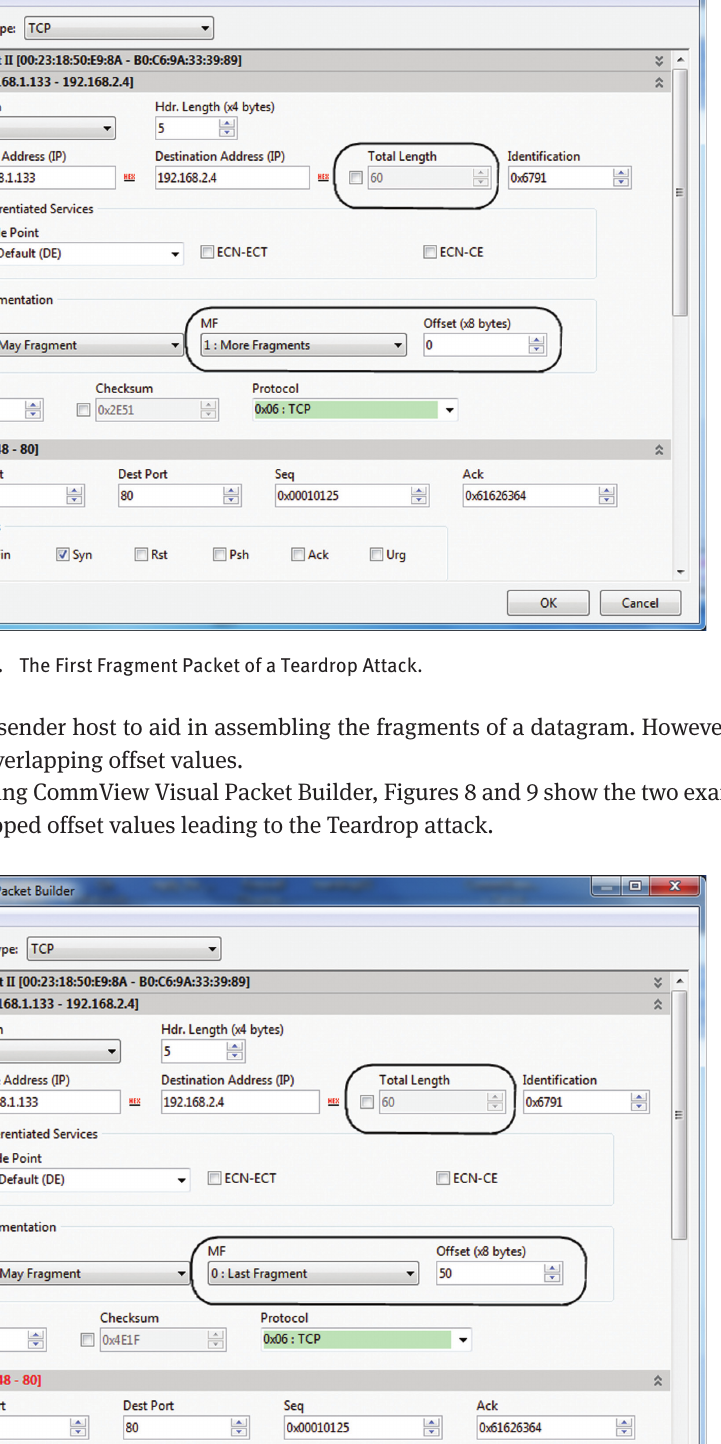
Figure 9. The Second Fragment Packet of a Teardrop Attack.